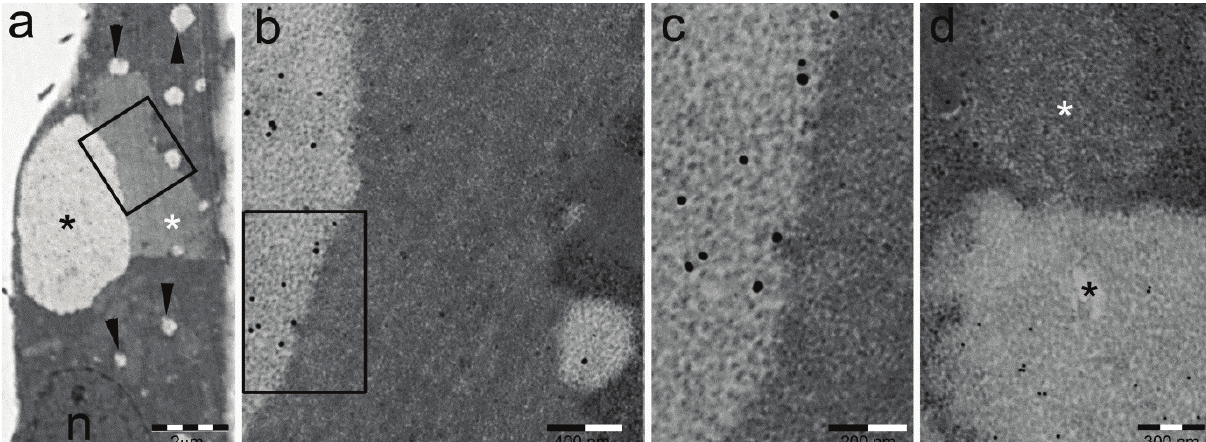
Figure 1. PaCSs and sequestosomes in HeLa cells. ( a ) Ultrastructural identification of a sequestosome (white asterisk) adherent to a large PaCS (black asterisk) in the cytoplasm of a HeLa cell cultured under basal conditions. Note the presence of several small PaCSs (some with arrowheads). N, nucleus; ( b , c ) The boxed area in ( a ) is enlarged to show PaCS distinctive barrel-like particles and FK1 antibody reactivity for polyubiquitinated proteins [19] (see the immunogold particles on light gray areas) as opposed to the thin granulo-fibrillary structure and FK1 unreactivity of the sequestosome (no immunogold particles on dark gray area); ( d ) Example of PaCS (black asterisk) showing proteasome immunogold reactivity next to an unreactive sequestosome (white